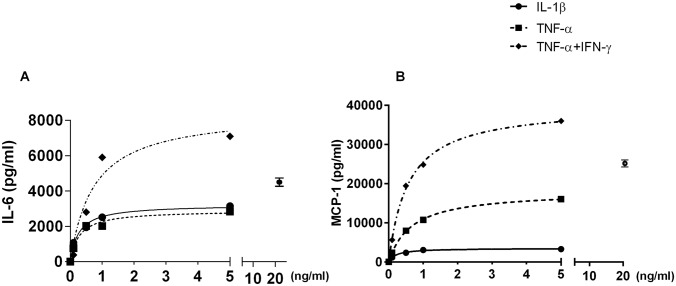
IL-6 and MCP-1 production as a function of IL-1ß and TNF-α concentrations in absence or presence of IFN-γ.IL-6 (A) or MCP-1 (B) concentration were measured after MSCs were treated with different concentration of TNF-α or IL-1β with or without IFNγ (50ng/ml). To precisely analyze the stimulating activities, basal Il-6 and MCP-1 expression (without treatment) have been subtracted from the concentrations measured under TNF-α or IL-1β with or without IFNγ stimulation. These basal concentrations were in the range of 10 to 20% of the maximal stimulating effect for IL-6 and in the range of 33% for MCP-1. The data are representative of 2 separate experiments. One over 3 measurements have been plotted for the clarity of the figures. The concentrations measured under 20 ng/ml concentration are represented as a single point (± SEM) as they did not fit with the one binding hyperbola which fitted all other concentrations obtained at different TNF-α concentrations.